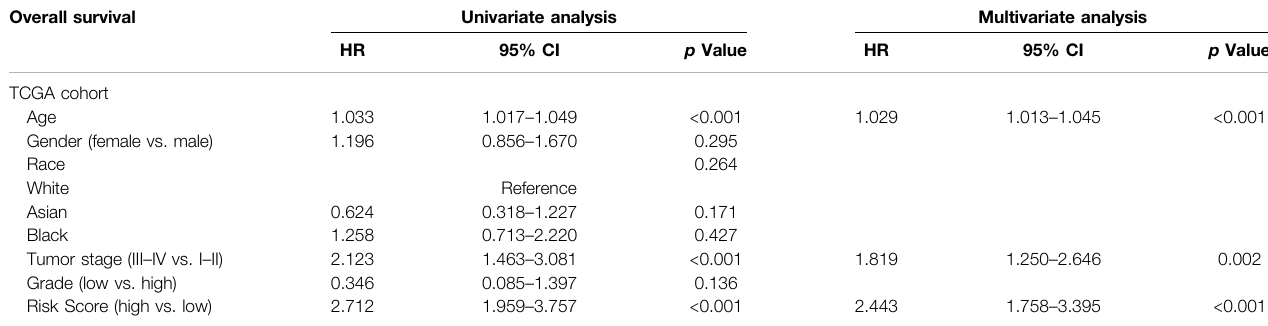
TABLE 2 | Multivariate and univariate Cox regression analyses of EMRGPS and other clinicopathologic characteristics for OS in the TCGA cohort. Overall survival Univariate analysis